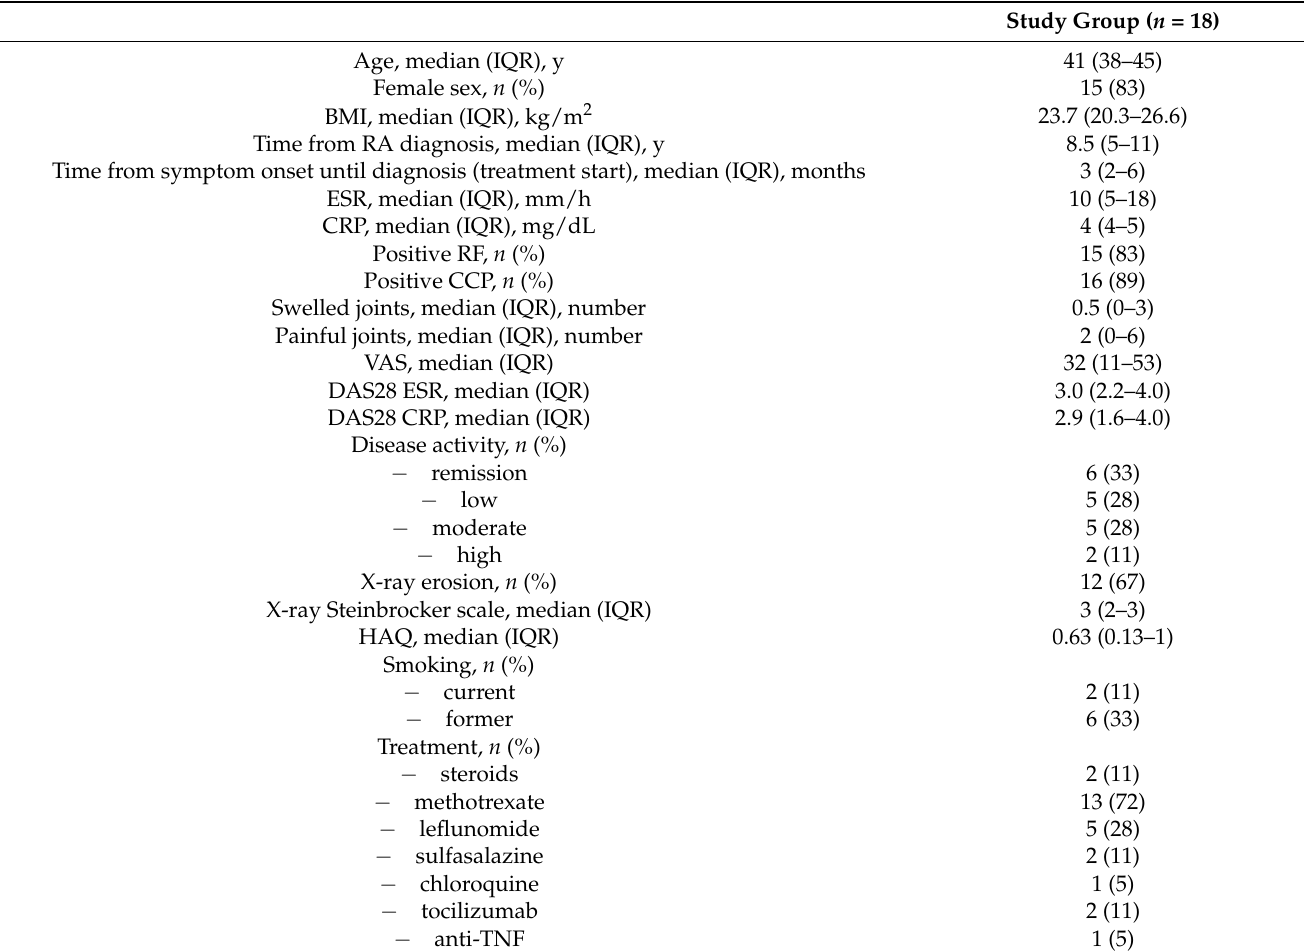
Table 1. Baseline characteristics of the studied group.